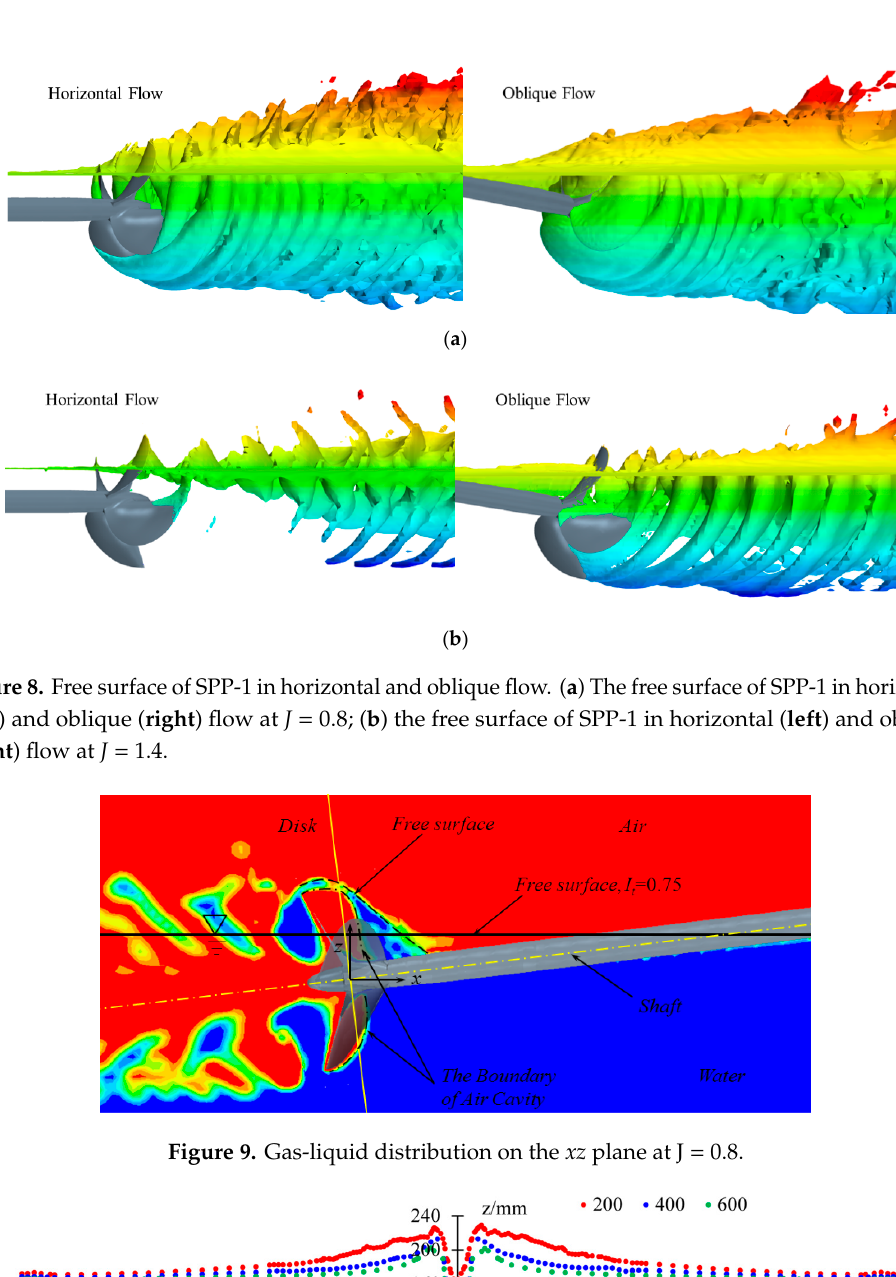
Figure 8. Free surface of SPP-1 in horizontal and oblique flow. ( a ) The free surface of SPP-1 in horizontal ( left ) and oblique ( right ) flow at J = 0.8; ( b ) the free surface of SPP-1 in horizontal ( left ) and oblique ( right ) flow at J = 1.4.